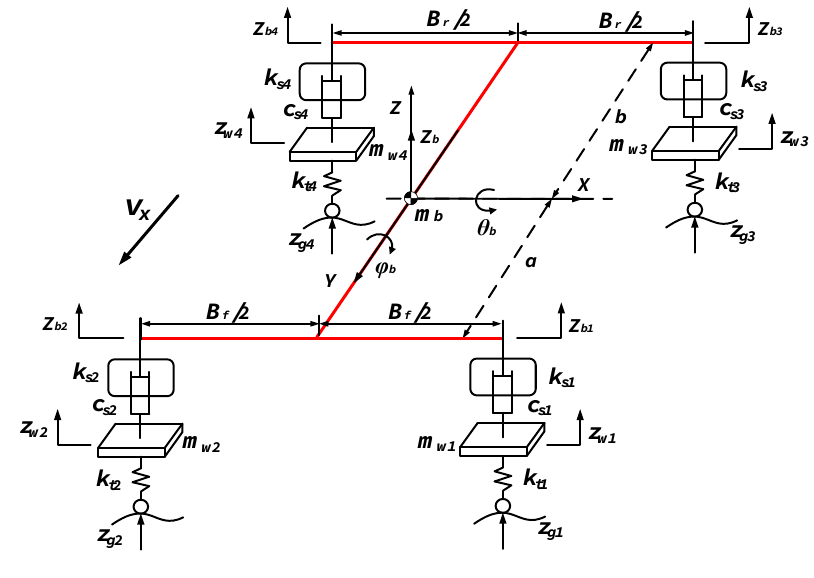
Figure 2. 7 degrees of freedom model of vehicle.